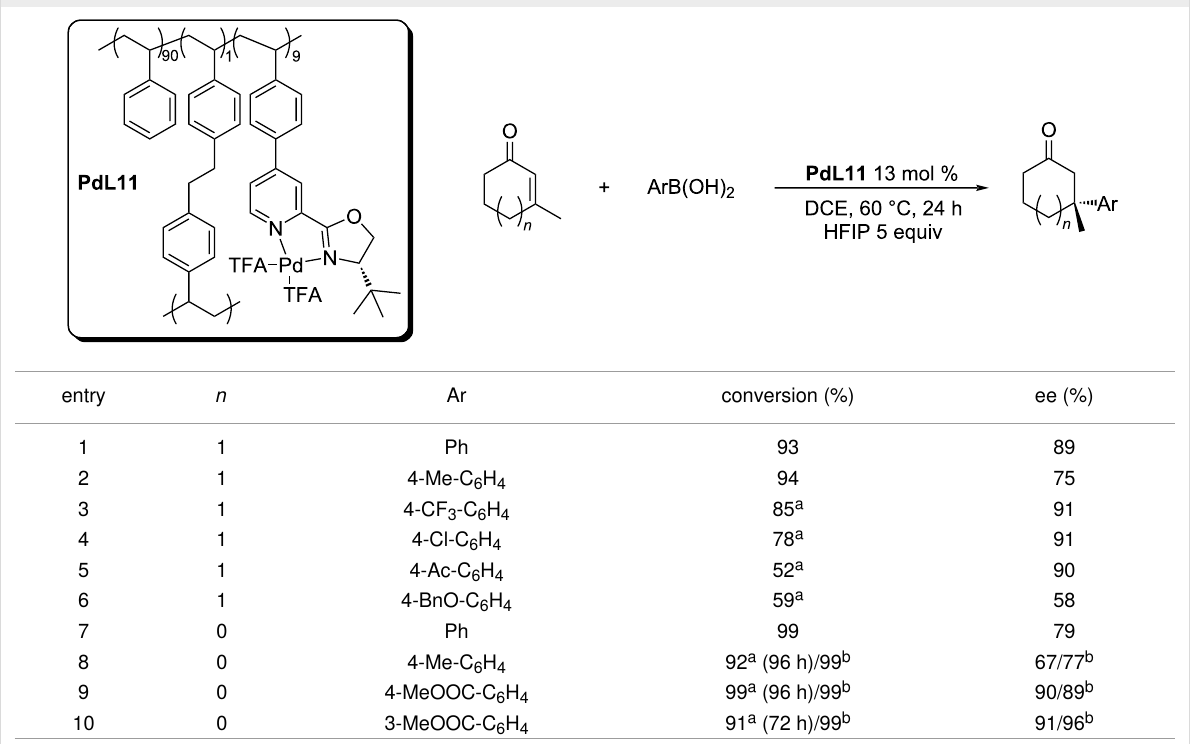
Table 29: Polystyrene-supported Pd complex PdL11 as catalyst for addition reactions of arylboronic acids to cyclic enones